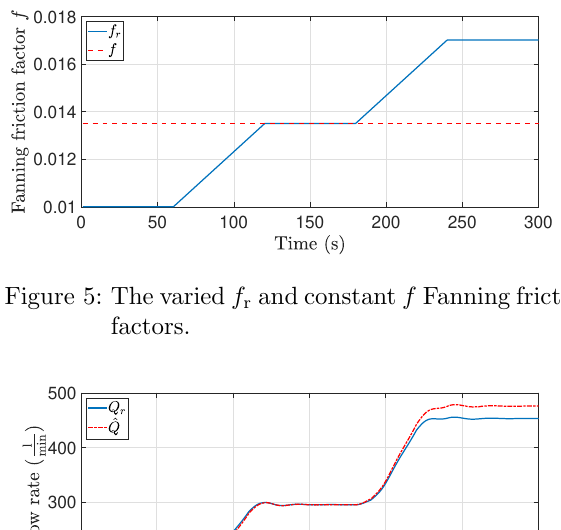
waves are also recorded.